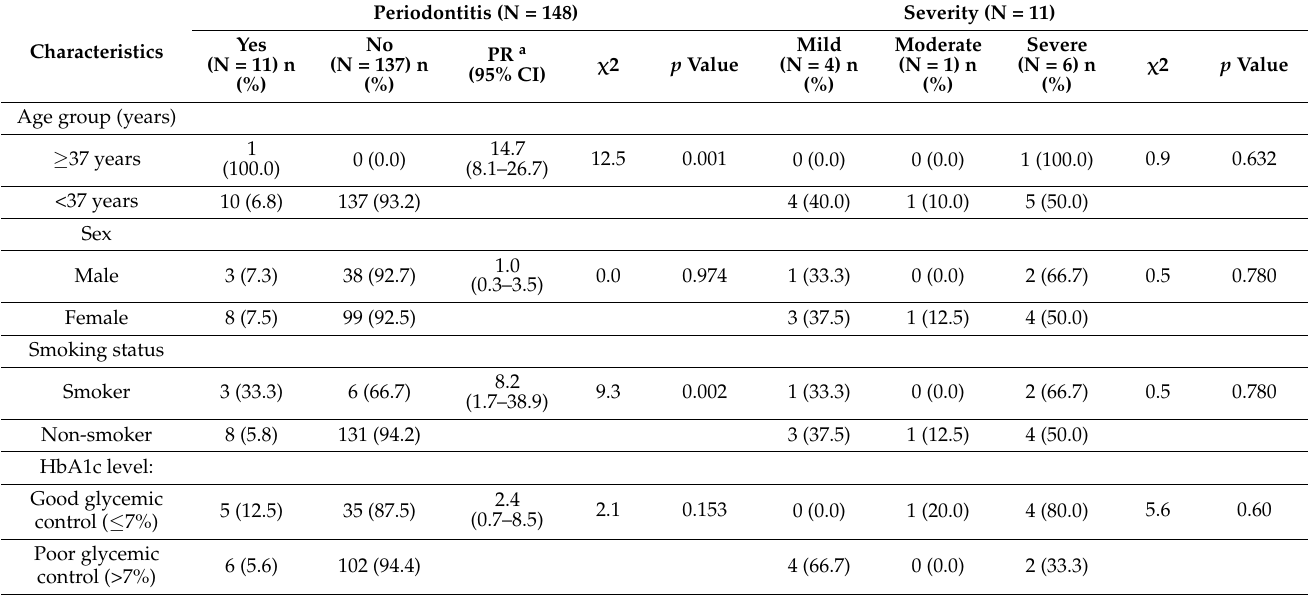
Table 2. The associated factors for periodontitis and its severity among type I diabetes